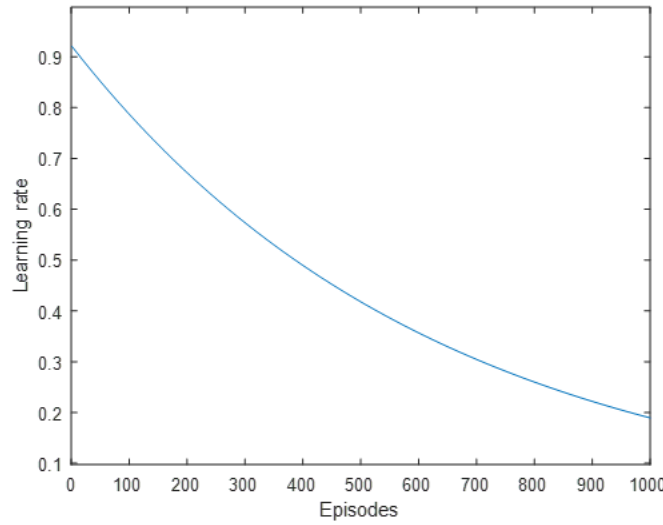
Figure 13. Reward discount plotted over episodes.